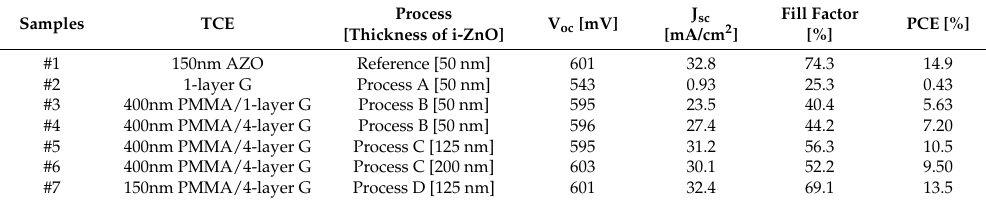
Figure 5. Schematic of multilayer arrangement in possible graphene-based CIGS device [48]. Graphene is incorporated at step-4 in all processes except standard process. Table 2. Graphene-composited copper indium gallium sulfide (CIGS) cell performance [48].